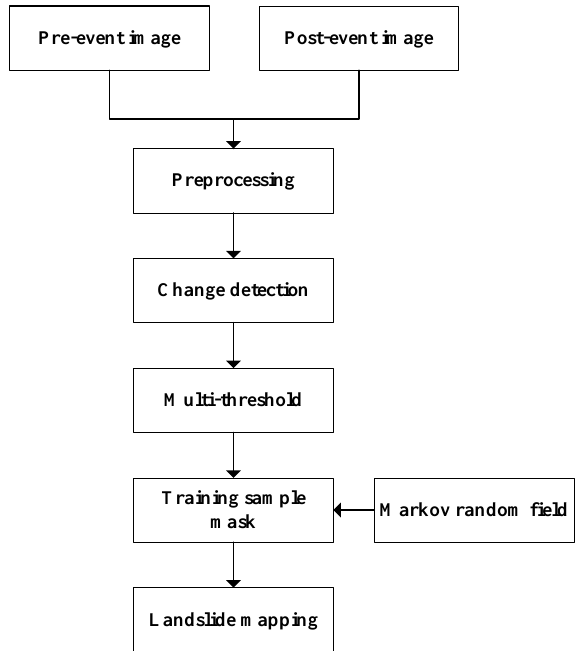
Figure 2. Flowchart of the proposed landslide mapping method